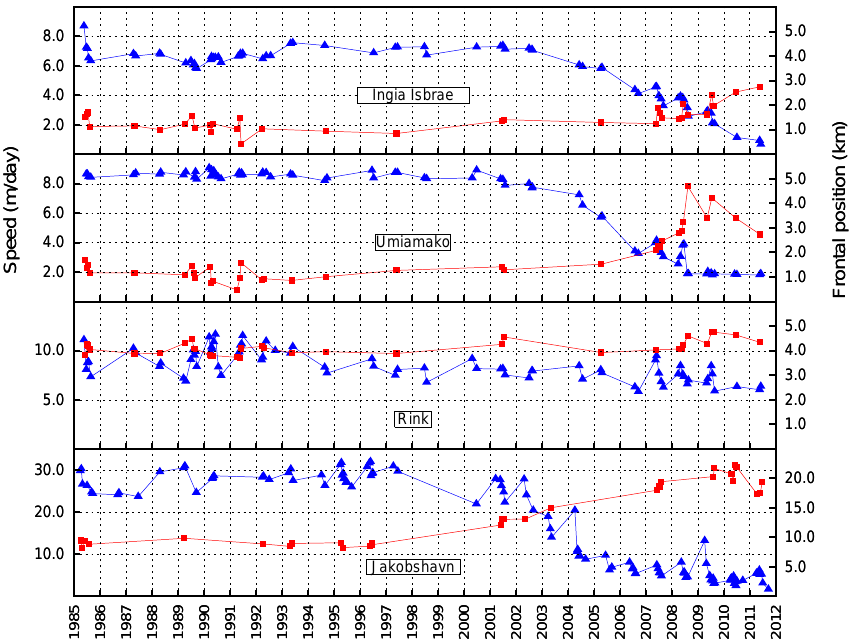
Fig. 6. Surface flow speeds (red squares) and frontal positions (blue triangles) for the Umiamako, Ingia Isbræ, Rink Isbræ and Jakobshavn Isbræ glaciers (see Fig. 1 for